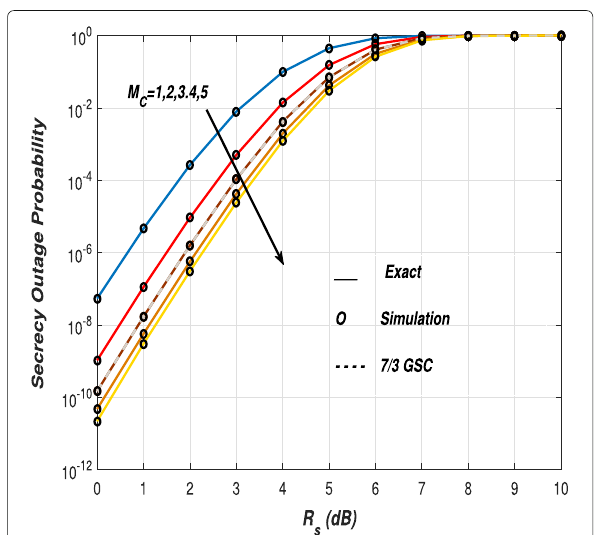
Fig. 1 Secrecy outage probability versus output threshold R s . Secrecy outage probability versus R s for different numbers of selected antennas M c with ψ 1 =30dB, (cid:3) 2 =10dB, (cid:3) t =7dB, σ =0.5,and M =7. Solid line represents the exact result and block dots represent the simulation result